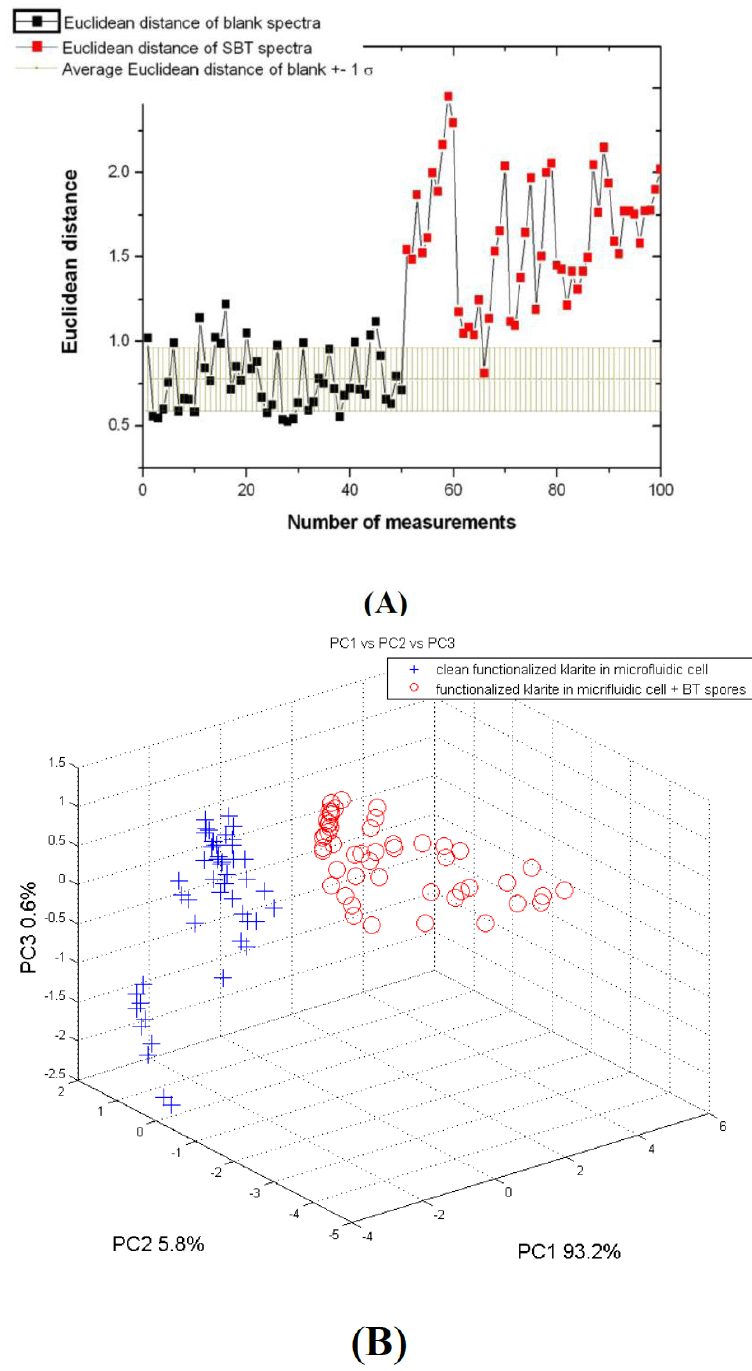
Figure 4. ( A ) Euclidean distance for the blank spectra (black dots) and SBT spectra (red dots) compared to the average value of the Euclidian distance obtained for the blank spectra (the brown line shows the range individuated by mean value ± 1 s B ). ( B ) First three principal component (PC) score plots of the SERS spectra acquired on the clean cartridge (blue crosses) and inoculated with SBT (red dots). Both Euclidian distance analysis and the principal component (PC) score plots show two groups of spectra well represented by the substrate and the spores of SBT likely captured by peptides (Figure 4). With reference to the results obtained from the Raman spectra acquired on SBA in the same experimental conditions described above, unexpected results were observed. In fact, for the